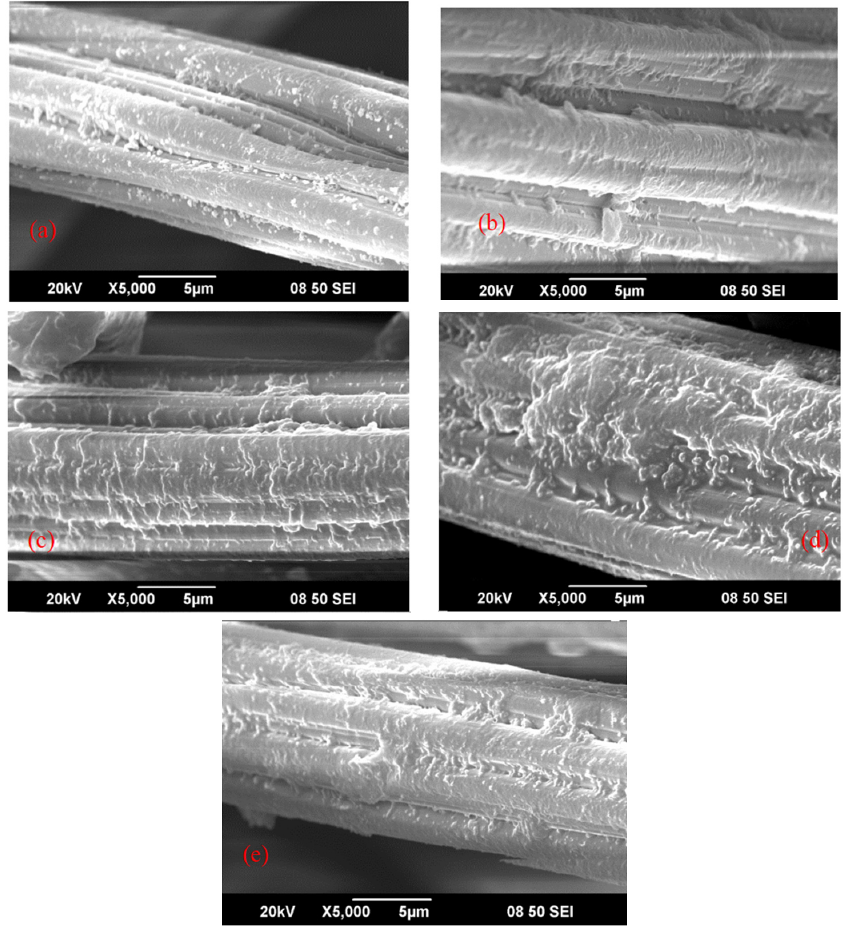
Figure 4. SEM micrographs illustrate the surface morphology of rayon flock synthetic leather after TMS plasma treatment with different discharge power: ( a ) untreated, ( b ) 30 W, ( c ) 40 W, ( d ) 50 W, ( e ) 60 W (treatment parameters: amount of TMS = 0.2 mL; flow rate of helium = 12.5 LPM; jet distance = 10 mm; treatment time = 30 s).